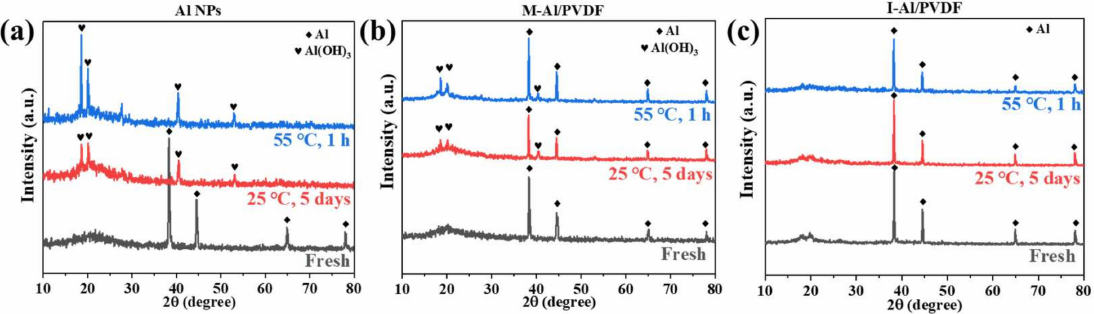
Figure 4. XRD patterns of Al NPs ( a ), I-Al/PVDF ( b ) and M-Al/PVDF ( c ) in the aging